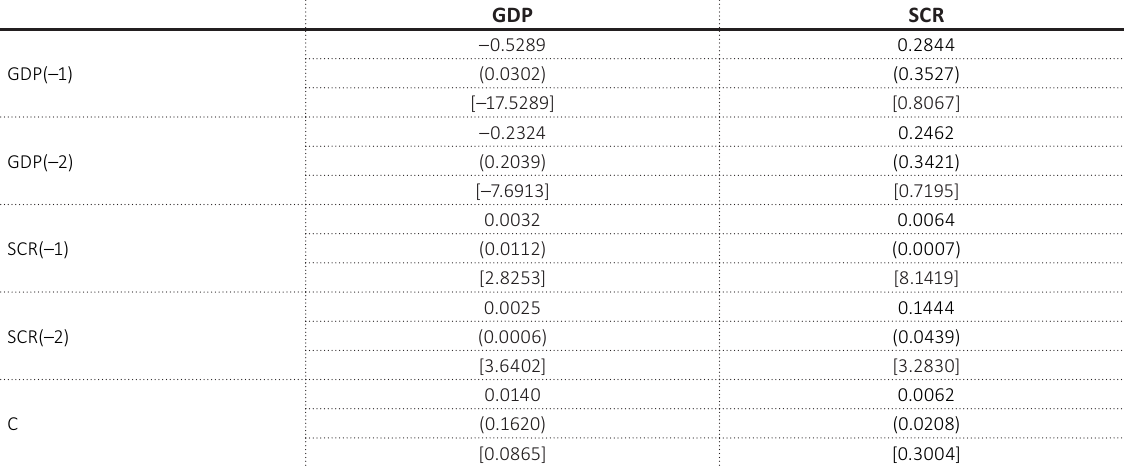
Table 3. VAR model